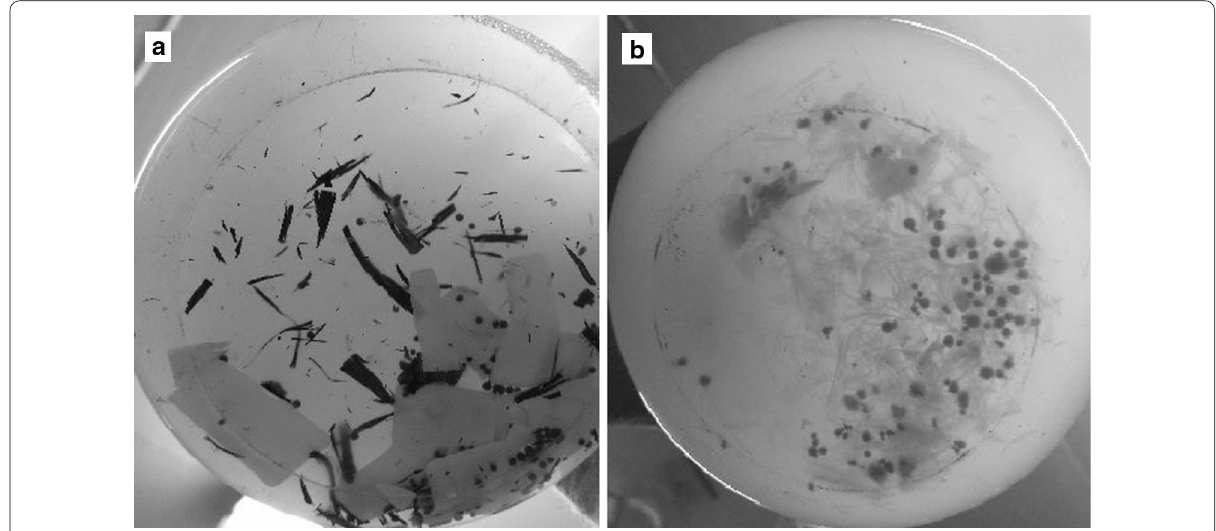
Fig. 4 PCL ( a ) and starch ( b ) films at the end of cultivation at 20 °C by